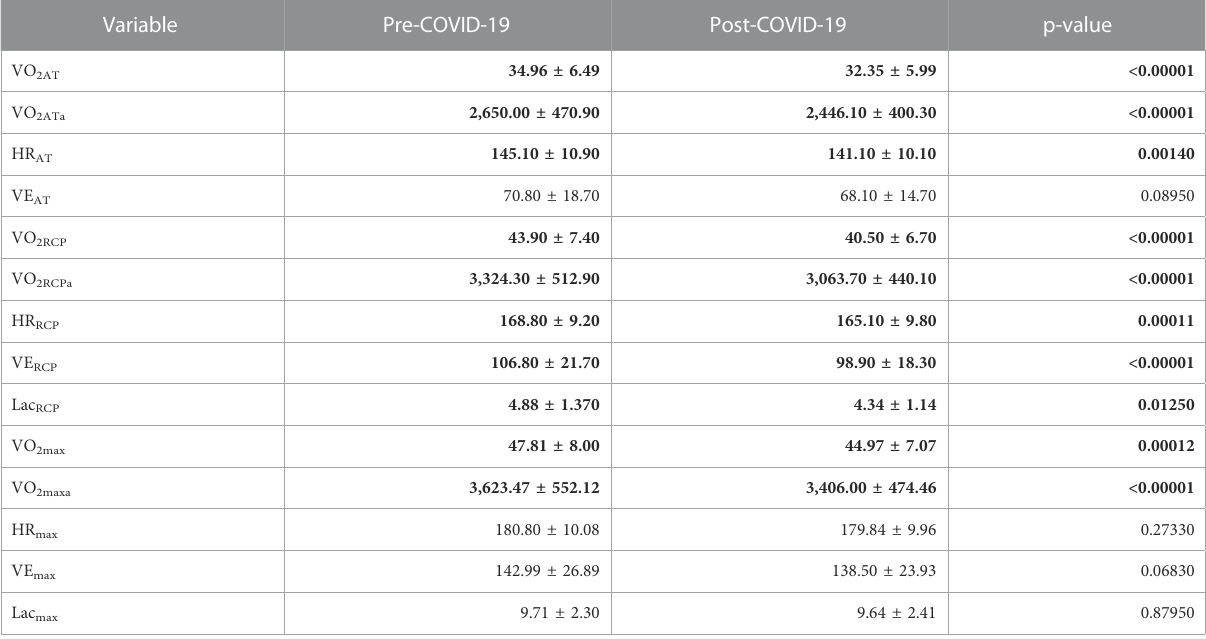
TABLE 2 Differences between pre- and post- COVID-19 CPET for study